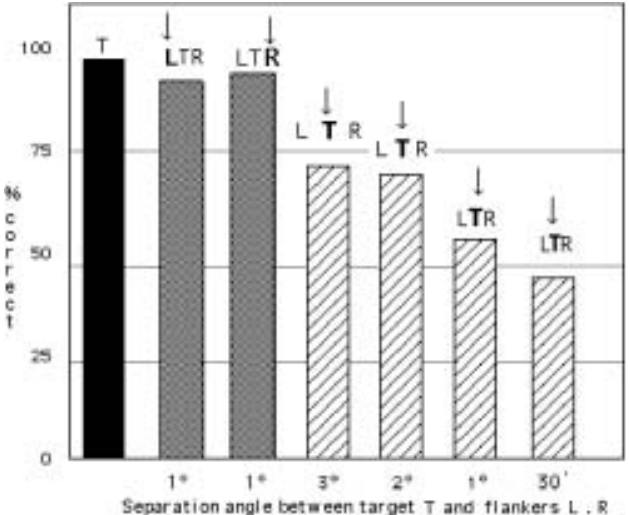
Fig. 6. Reading one letter in three situations: reading the target letter in isolation (T); reading the left (L with arrow) or the right (R with arrow) flanker letter in the three letter display (LTR); reading the target letter (T with arrow) between two flankers (LTR). X axis: distance (in degrees of visual angle) between the target letter and the two distractors; Y axis: percent correct. Ceiling performances for displays T alone, L(TR), (LT)R. For (L)T(R) displays performance decreased regularly with the proximity of the